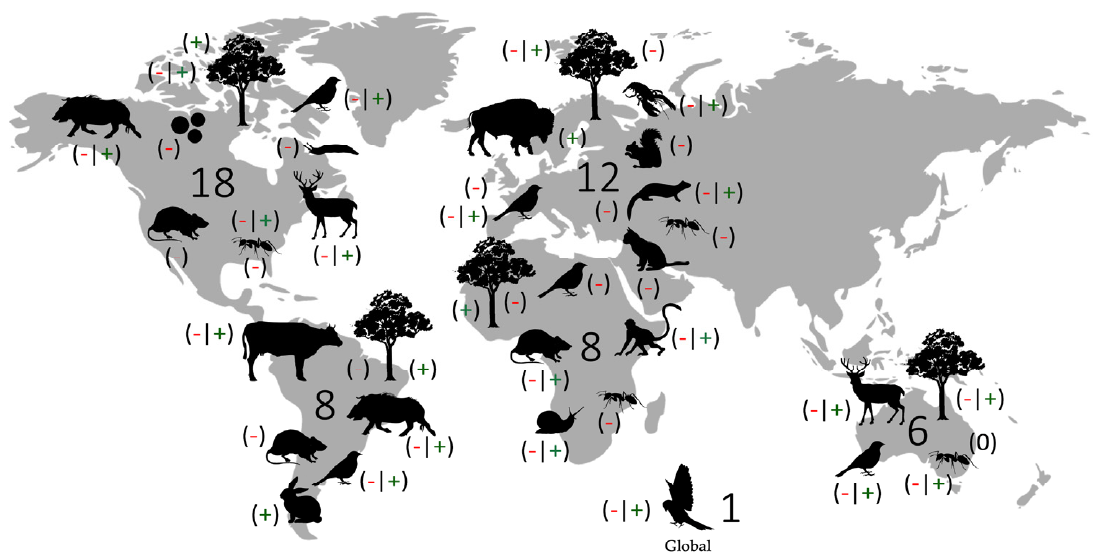
Figure 1. General overview of exotic taxa distribution and their ecological impacts on native seed dispersal systems, including the number of studies reviewed for each continent. Symbols indicate the effect exerted by exotic species, classified as negative ( − ), positive (+), mixed ( − |+), and neutral (0).